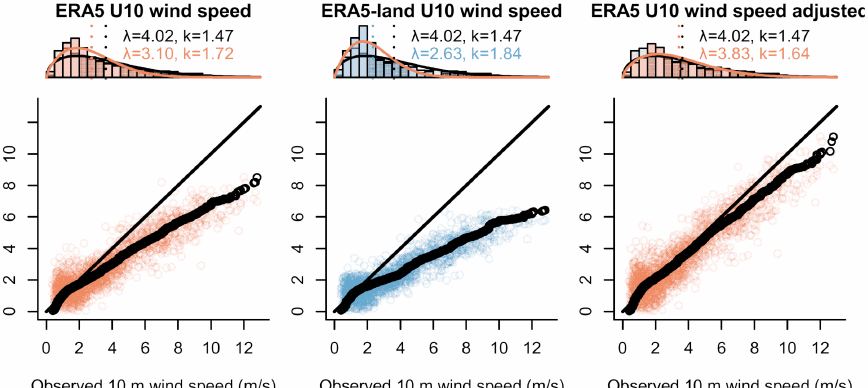
Figure 11. Observed wind speed and direction 10 m above ground at the Holzkirchen site compared to the ERA5 reanalysis for the period 7 December 2018 to 28 February 2019.